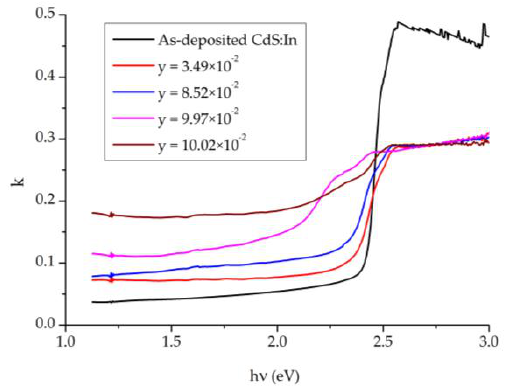
Figure 9. The extinction coefficient k of a CdS:In film and the CdS 1−y Te y thin films with comparable thickness and different composition y.